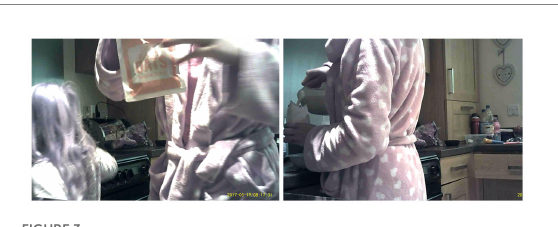
FIGURE 3 Subdividing large portions according to the visual representation of the portion on the packaging.